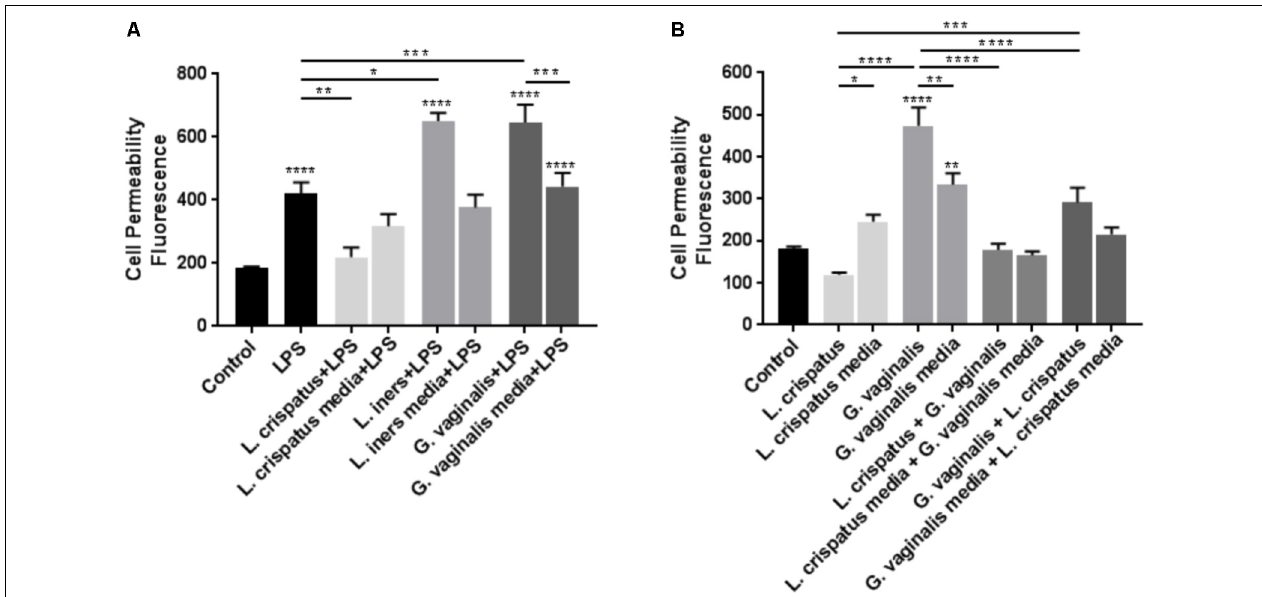
FIGURE 5 | Lactobacillus crispatus bacteria-free supernatants mitigate the LPS- or G. vaginalis -induced increases in cell permeability in ectocervical cells. (A) Cell permeability was measured in ectocervical cells after exposure to bacterial free supernatants (10% v/v) from L. crispatus , L. iners , and G. vaginalis for 24 h followed by LPS (25 µ g/ml) exposure for additional 24 h. Bacterial growth media containing LPS acted as a negative control for the three bacteria-free supernatants tested. (B) Cell permeability was measured in ectocervical cells after exposure to bacterial free supernatants from L. crispatus and G. vaginalis alone or in combination. Ectocervical cells were exposed to L. crispatus supernatants (5% v/v) on day 1 followed by G. vaginalis supernatants (5% v/v) on day 2 or vice versa for 24–48 h. Bacterial growth media alone acted as a negative control for the three bacteria-free supernatants tested. Cell permeability is expressed as fluorescence OD measurements from a fluorescent plate reader and is indicative of the movement of FITC-dextran from the top to the bottom insert of a transwell chamber system. Values are mean ± SEM. Asterisks over the individual bars represent comparisons to control; asterisks over solid lines represent comparisons between treatment groups. ∗ p < 0.05, ∗∗ p < 0.01, ∗∗∗ p < 0.001, ∗∗∗∗ p <